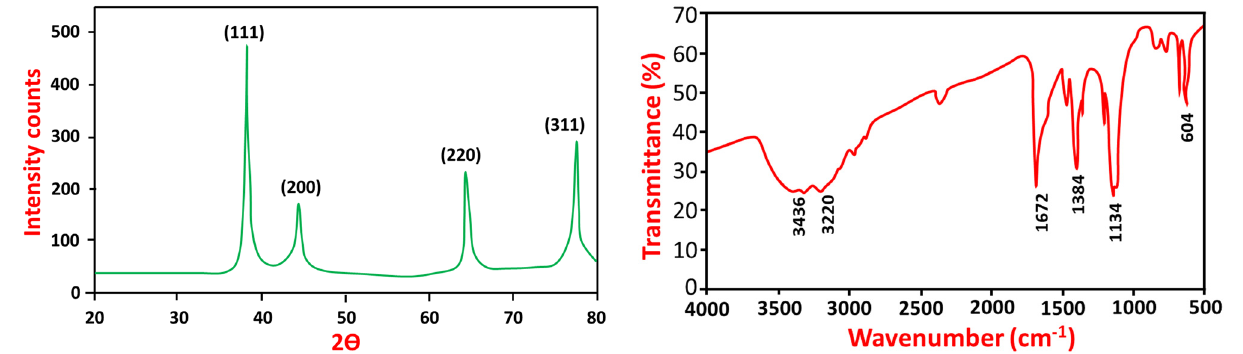
Figure 3: XRD pattern of the prepared AuNPs. Figure 4: FTIR spectrum of the prepared AuNPs.